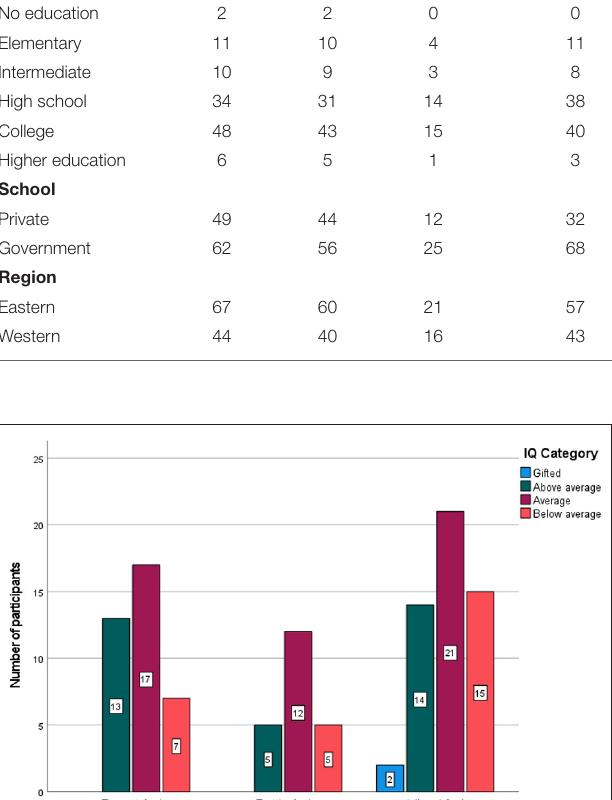
Bottle feeding ( n = 22)